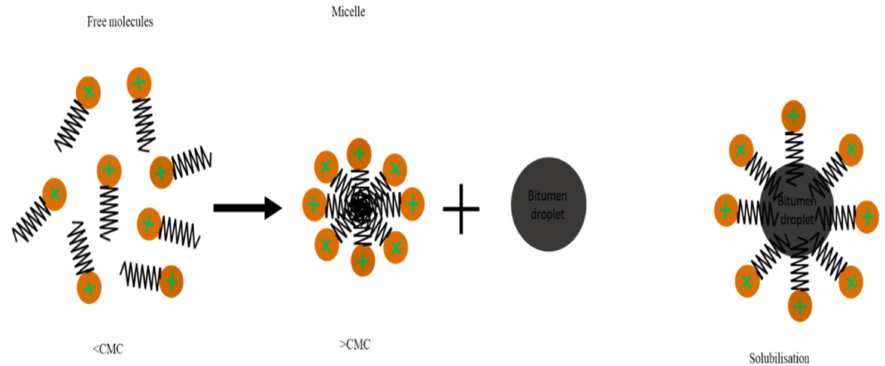
Figure 12. Schematics of micelle formation at concentrations above the CMC and bitumen droplet dispersion by micelle in the aqueous phase.